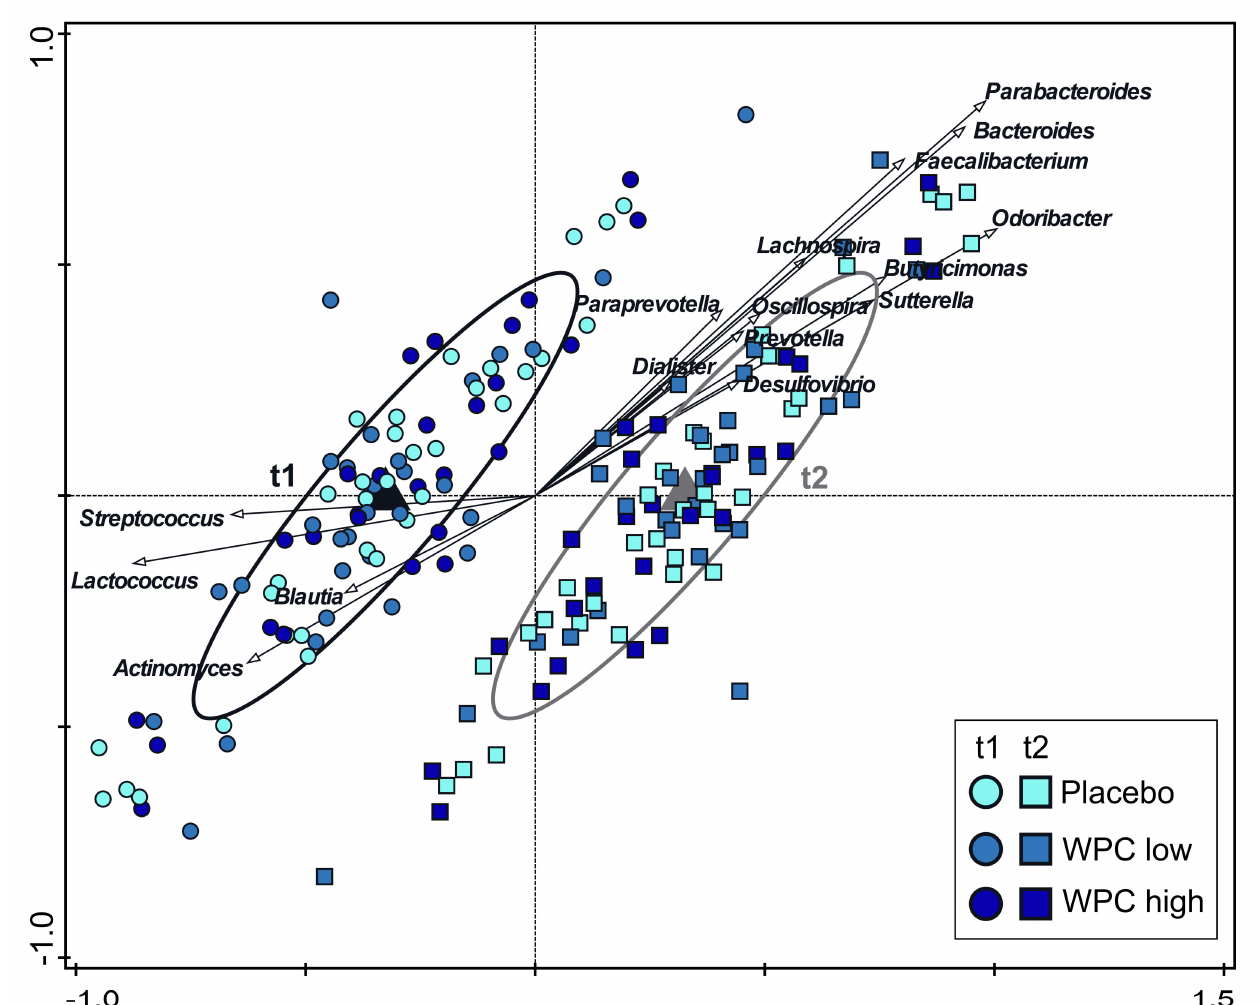
Figure 3. Redundancy analysis (RDA) of the OTU level. OTUs were used as response data, and time point was explanatory data; the bacterial genera that contributed most are plotted. The covariance attributed to subject was first fitted by regression and then “partialled out” (removed) from the ordination. Variation explained by time point was 2.5%, p = 0.002. Ellipses cover 66% of the observations associated with each time point. Circles are t = 1 samples, and squares are t = 2 samples. Samples are separated based on time point on the first (horizontal) constrained axis, and the second (vertical) unconstrained axis captures a fraction of variation explained by factors other than time